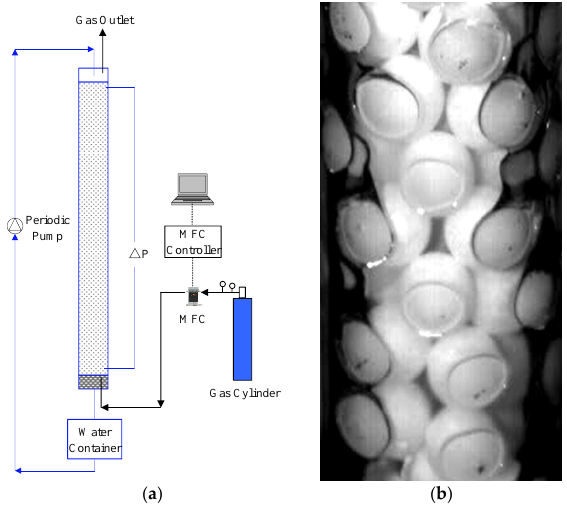
Figure 2. Experiment Setup, ( a ) Schematic diagram of the experiment setup; ( b ) Image of plastic spheres.